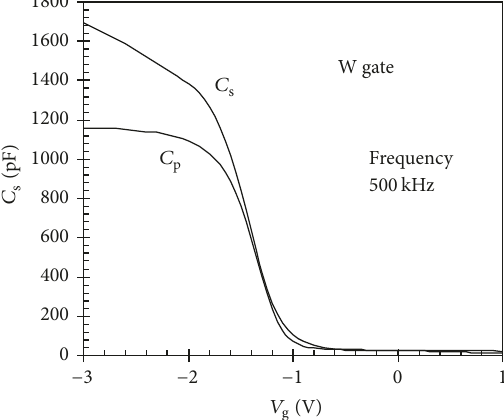
- V with 𝐶 - V at 500 kHz in the case of a W gate. s p